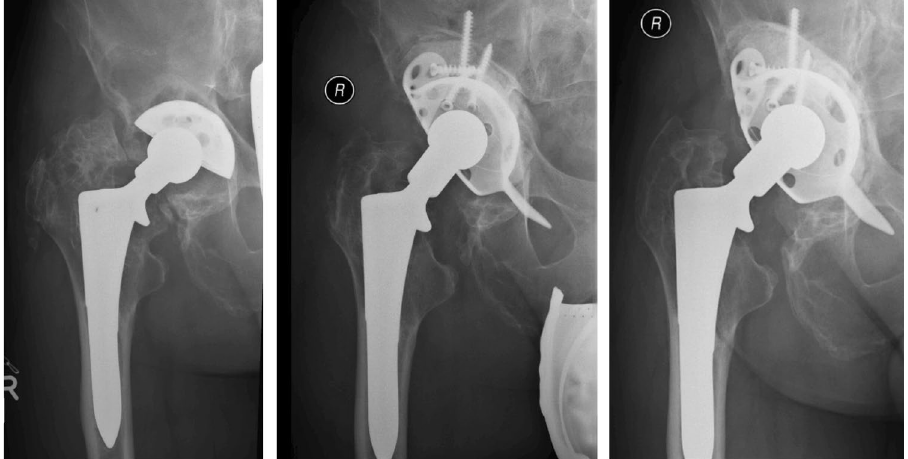
Figure 7. Preoperative Paprosky type 3a defect and postoperative controls after 1 week and 6 years.